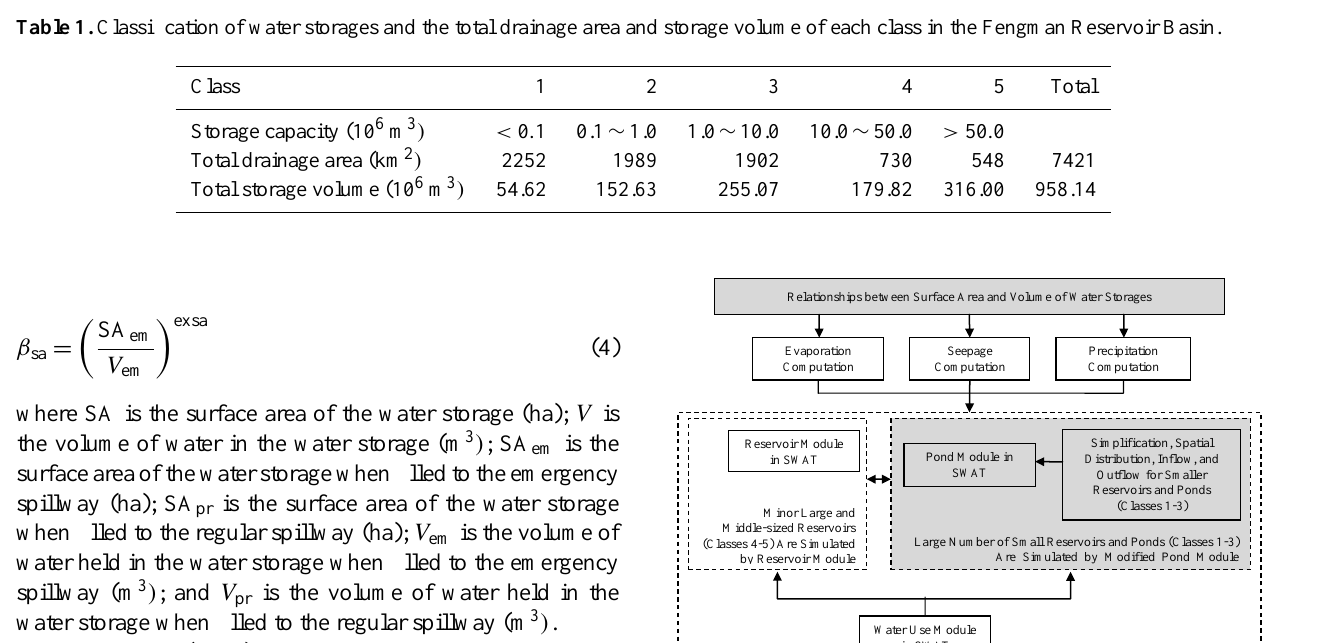
Water balance and transport through a network combining both sequential and parallel stream and storage links